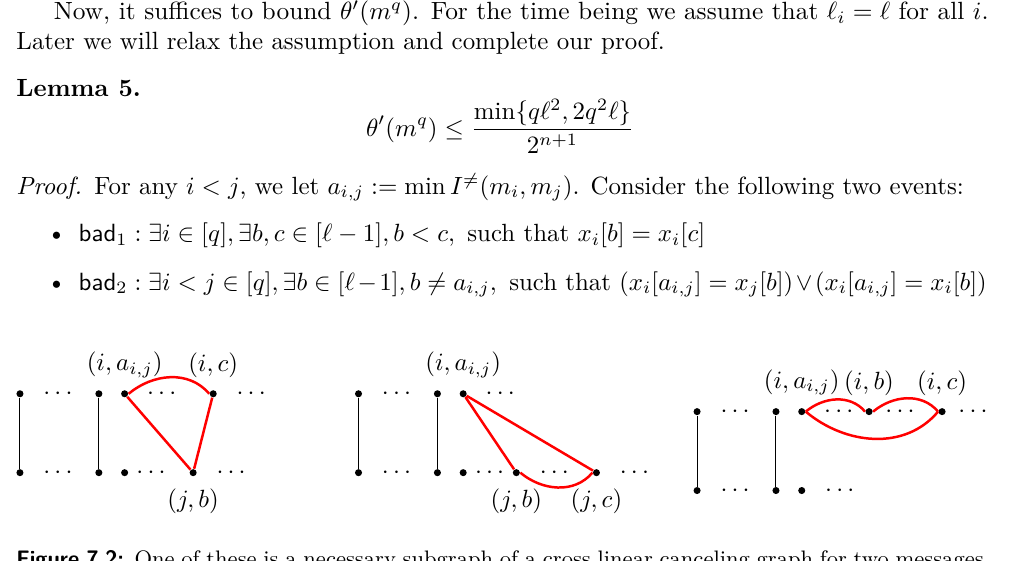
Figure 7.2: One of these is a necessary subgraph of a cross linear canceling graph for two messages with same block-lengths. A red or (solid) black line between two nodes signifies equality between them. Red is used when two blocks with different positions collide. Black is used when two blocks with same position